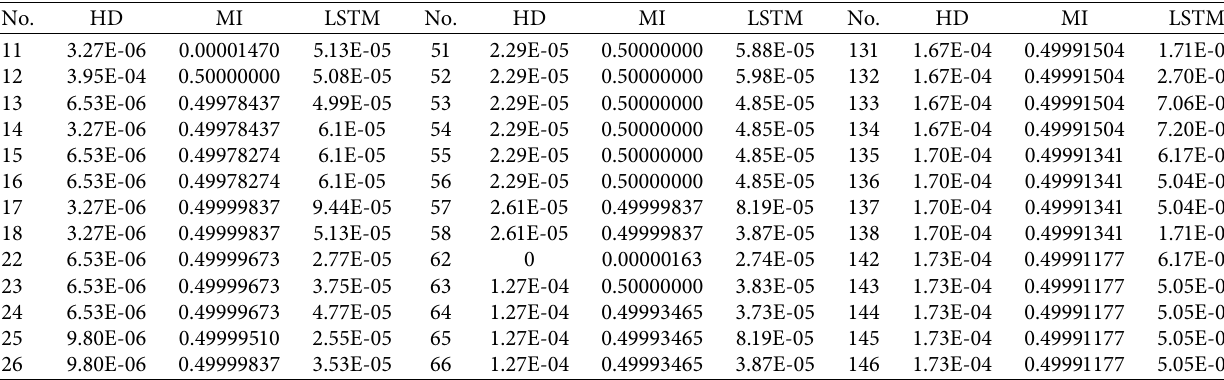
Figure 11: Curve after Table 4: Comparison of the filling error rates for missing data in the pressure of 1# SG.